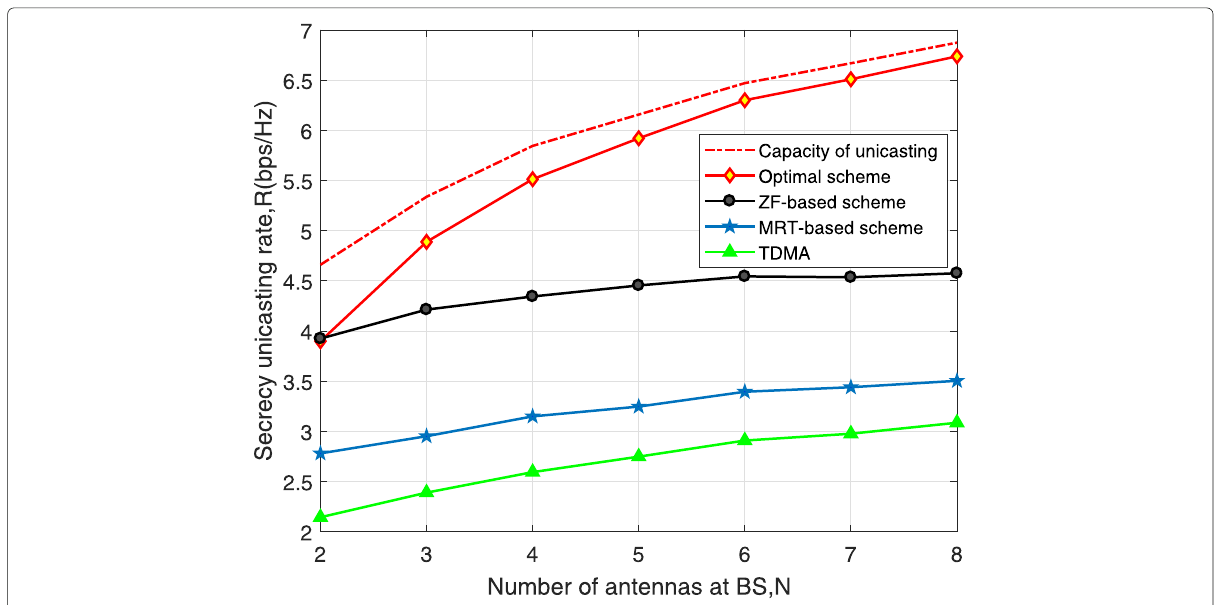
Fig. 3 Secrecy unicasting rate versus the number of users with P =